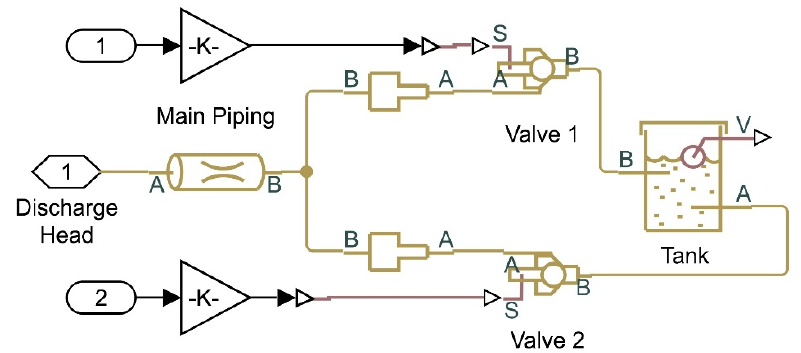
Figure 7. Model of the piping system developed in Simulink.